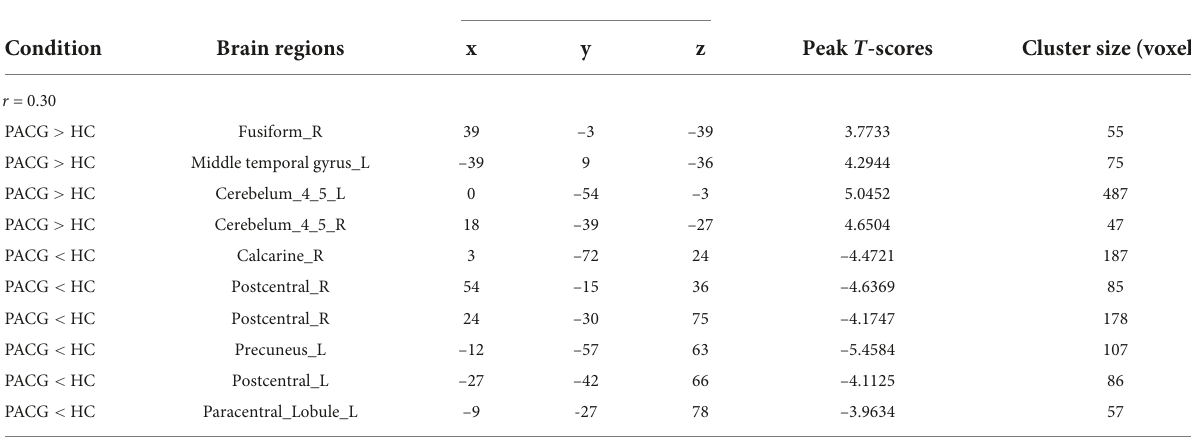
TABLE 5 Significant differences in the DC between the two groups ( r =